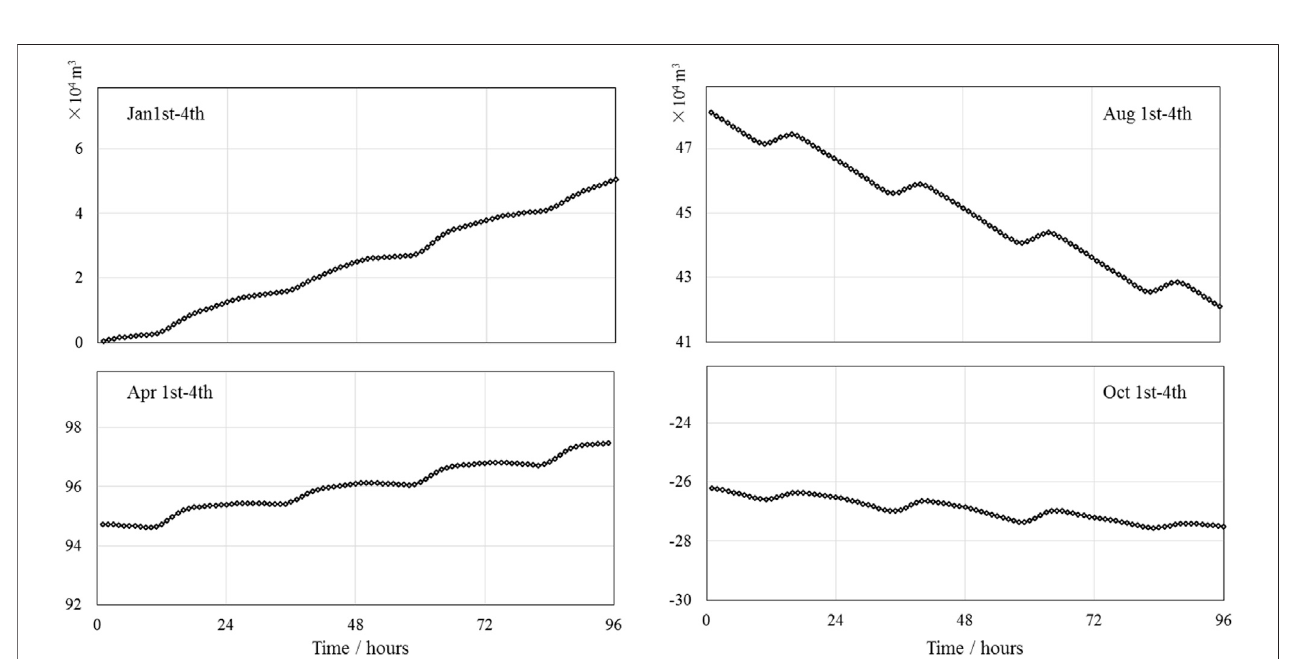
FIGURE 11 | Water volume variation during the selected days when α w (cid:2) 0 . 74.